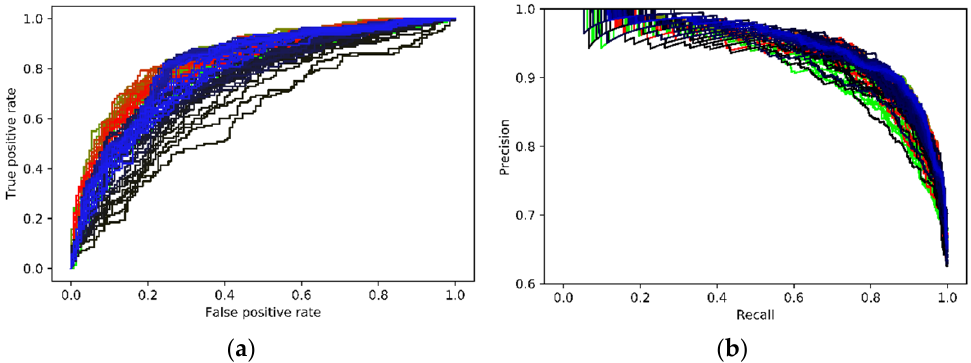
Figure 5. Performance on the fusion of the UCF-Crime and the XD-Violence datasets: ( a ) the evolution of AUCs; ( b ) the evolution of PRCs. (The curves were overlapped with the ones in Figure 4 to show the differences. The color of the curve transits from dark—early epochs, to blue—late epochs).